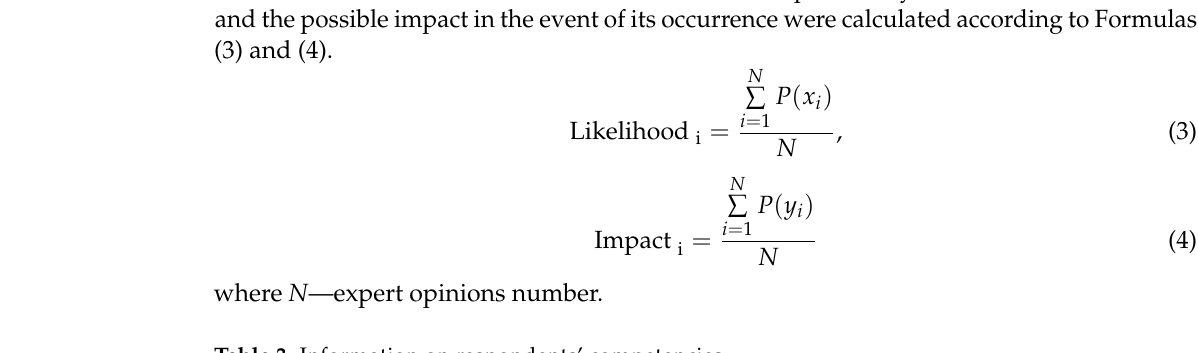
Table 3. Information on respondents’